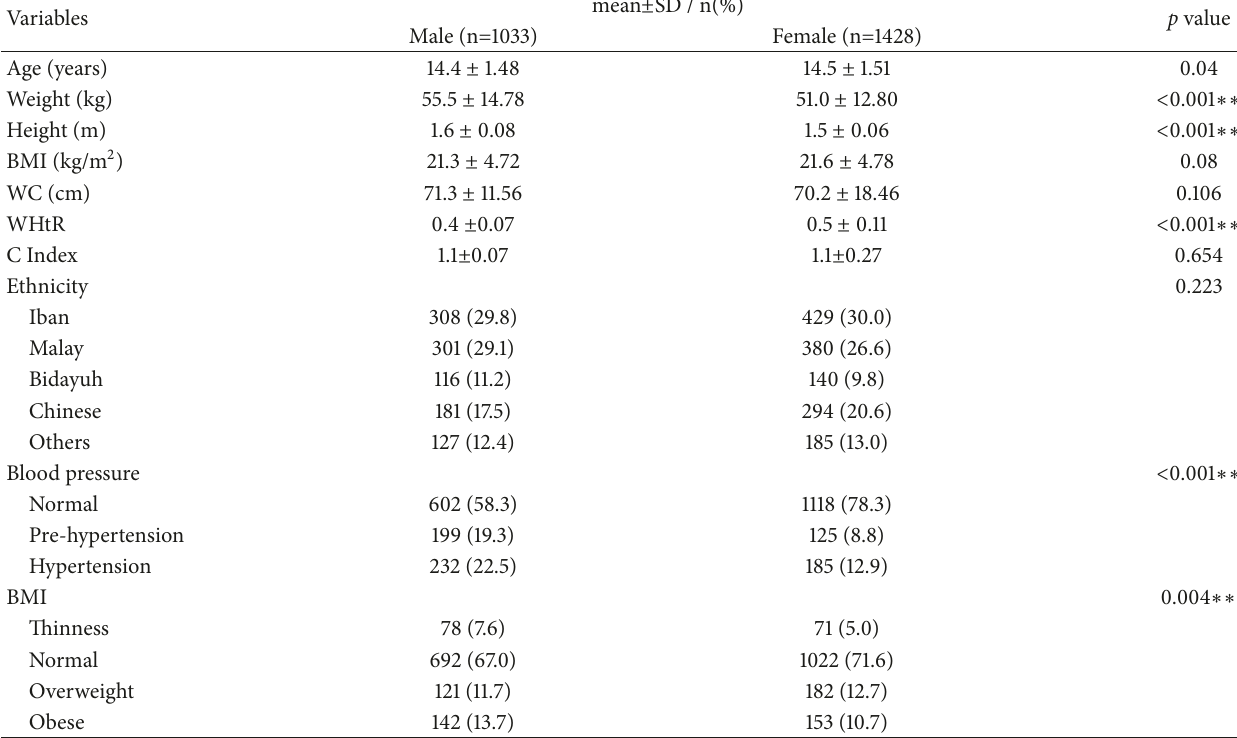
Table 1: Sociodemographic and health profile among male and female respondents (N=2461).